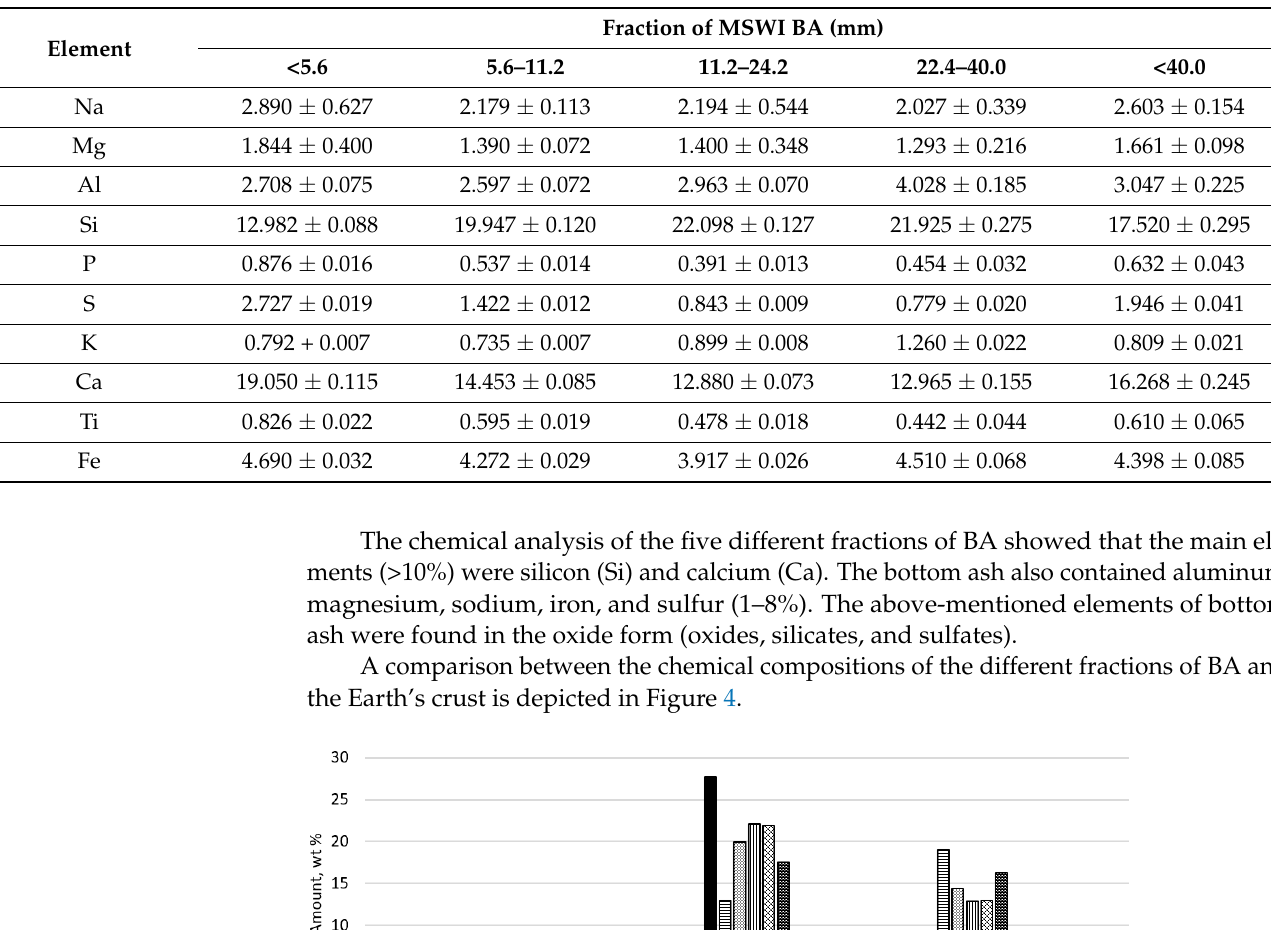
Table 1. Major elements of five different fractions of untreated MSWI bottom ash (wt %).